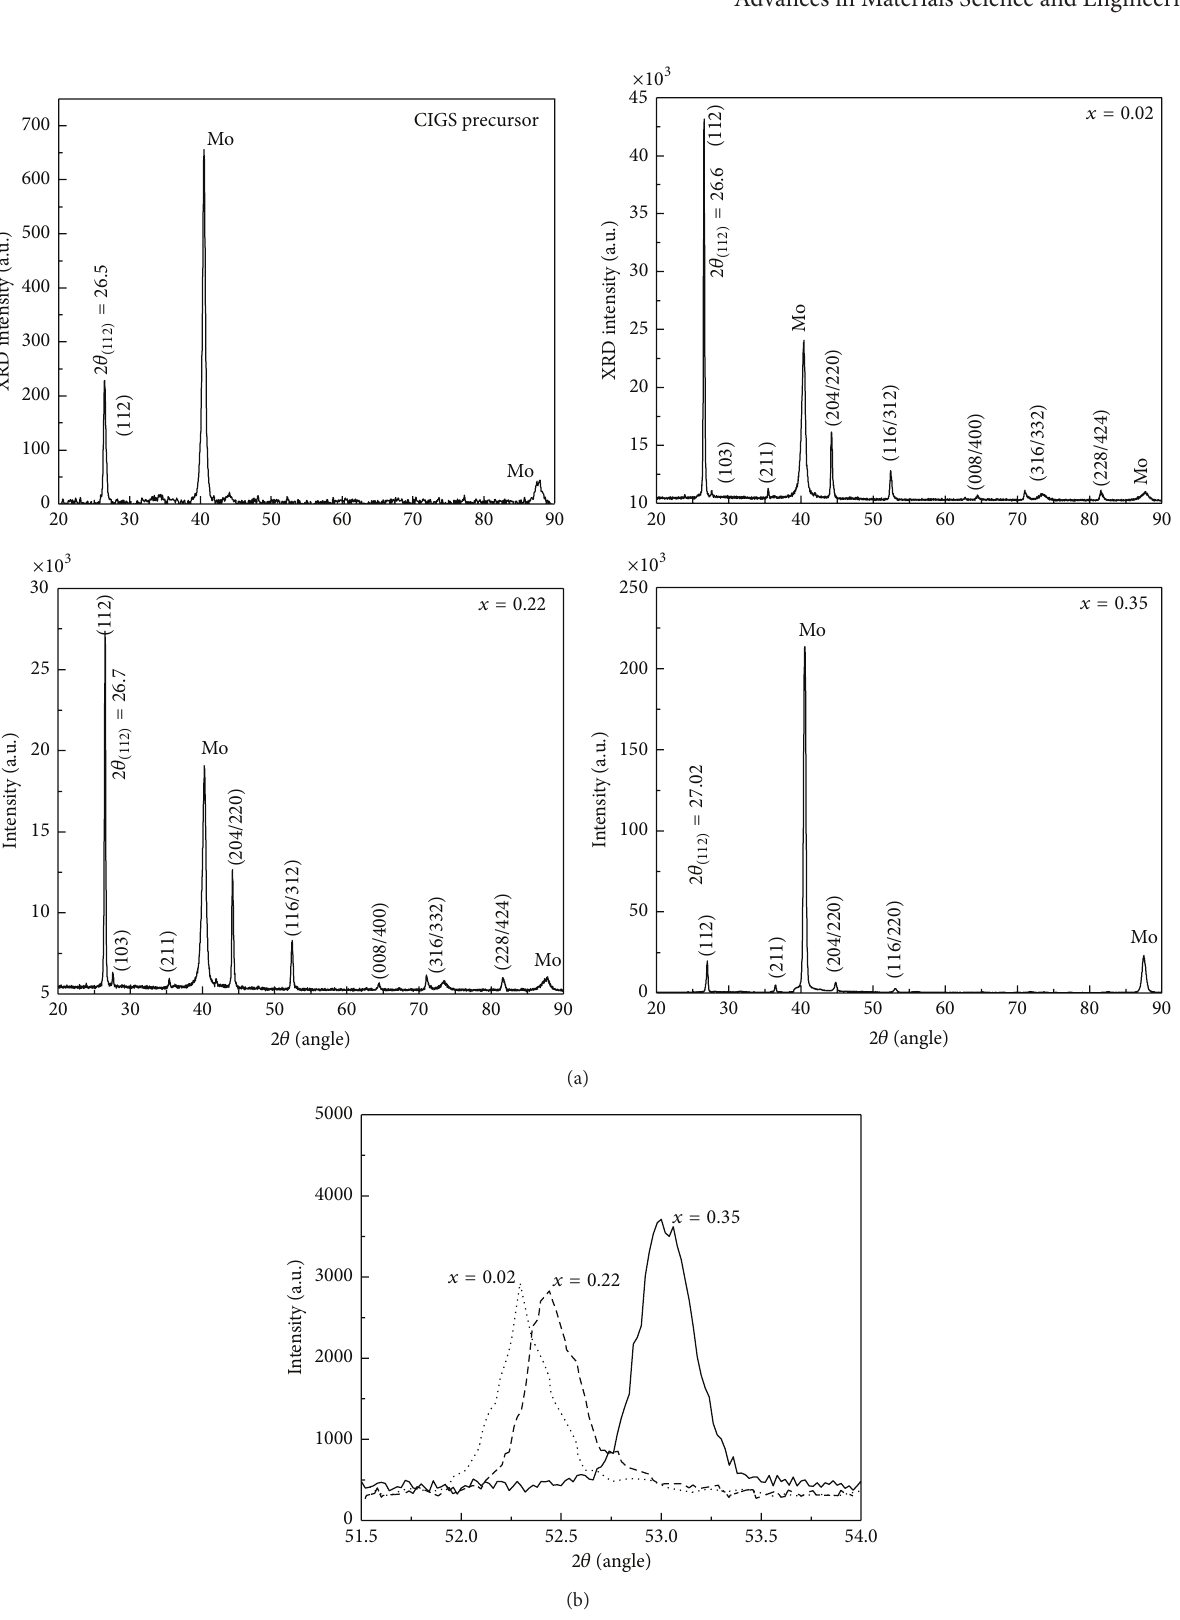
Ga Se 2 selenized thin films with different gallium incorporations ( x = 0.02, 0.22, x x Ga Se 2 as function of gallium concentration ( x = 0.02, 0.22, x x